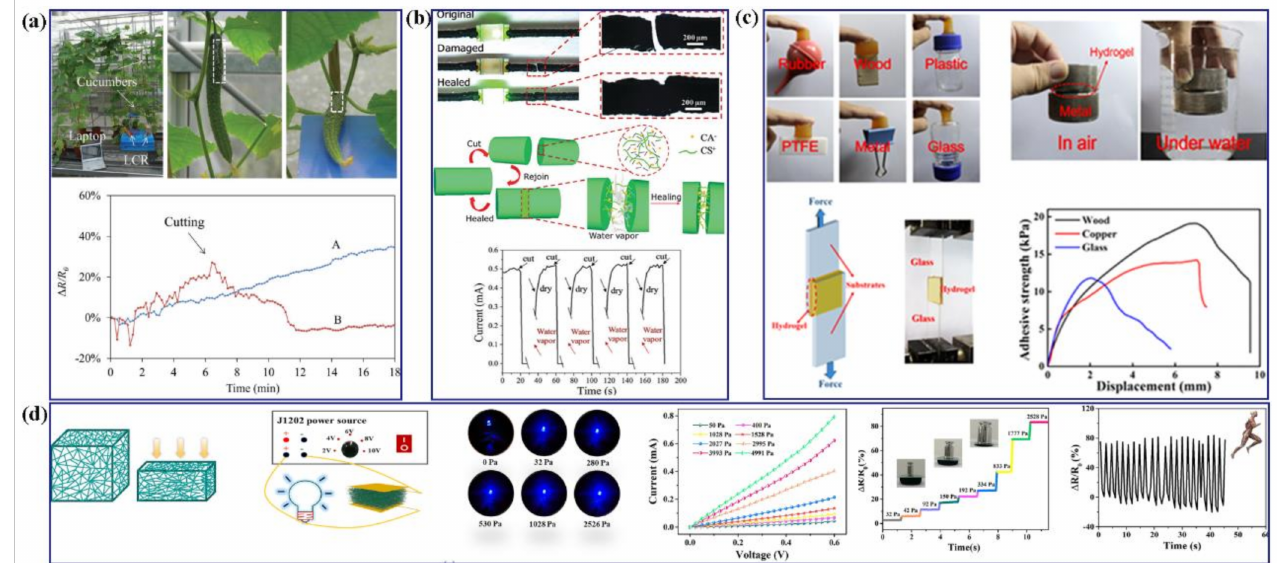
Figure 10. ( a ) Fruit growths of cucumbers were being measured. LCR meters were used to measure the real-time resistance values of the sensors written on a cucumber. Reproduced with permission from [87]. Copyright 2017, WILEY-VCH; ( b ) optical microscopy images of a CS/CNT fiber at original, damaged and healed states to turn on or off a LED light bulb, schematic illustration of the healing process of a CS/CNT fiber exposed to water vapor, repeated healing and recovery of electrical properties for five cuts on the fiber. Reproduced with permission from [90]. Copyright 2018, Royal Society of Chemistry; ( c ) self-adhesion properties of CS/PAA/TA@CNC-60, hydrogels tightly adhered between skin and various substrate surfaces, including rubber, wood, plastic, PFTE, metal and glass, schematic illustration of lap shear test, representative curves of adhesion shear force versus displacement for hydrogels with various substrates (wood, copper and glass). Reproduced with permission from [94]. Copyright 2019, American Chemical Society; ( d ) stress-sensing models of PANI/BC/CH aerogel, the schematic diagram of the LED light was applied to test the electrical response of the PANI/BC/CH aerogel under a power supply of 2 V in a series circuit, response of the LED light varies with the applied pressure on the PANI/BC/CH aerogel, current-voltage (I-V) curves of PANI/BC/CH aerogel under different pressures, the curve of ∆ R/R 0 versus time when PANI/BC/CH aerogel-based sensor was attached on the bottom of a shoes as a pedometer for walking. Reproduced with permission from [96]. Copyright 2019,